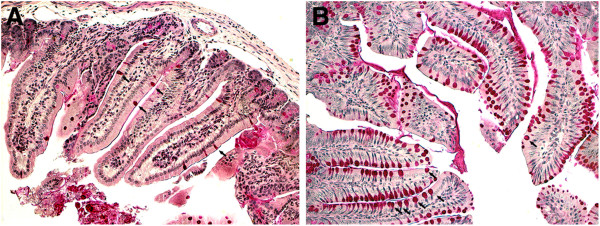
Intestinal section: A) control (DMSO), B) treatment (compound E). Goblet cells in red. Please note the increase of intestinal goblet cells in B over A (20× magnification).